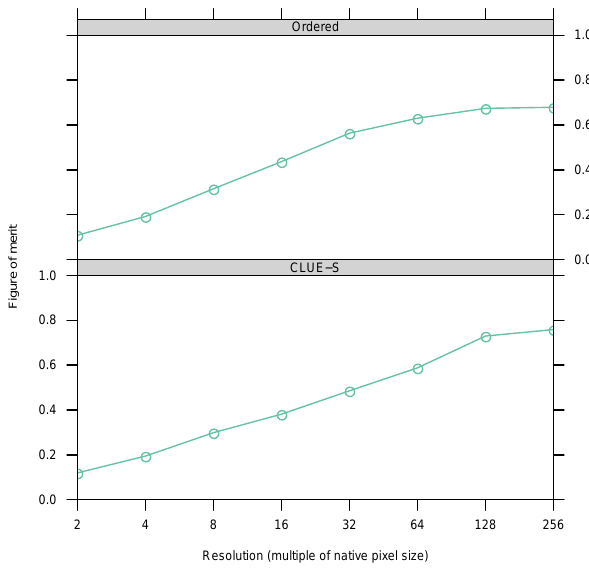
Figure 8. Figure of merit scores corresponding to the agreement budgets depicted in Fig.